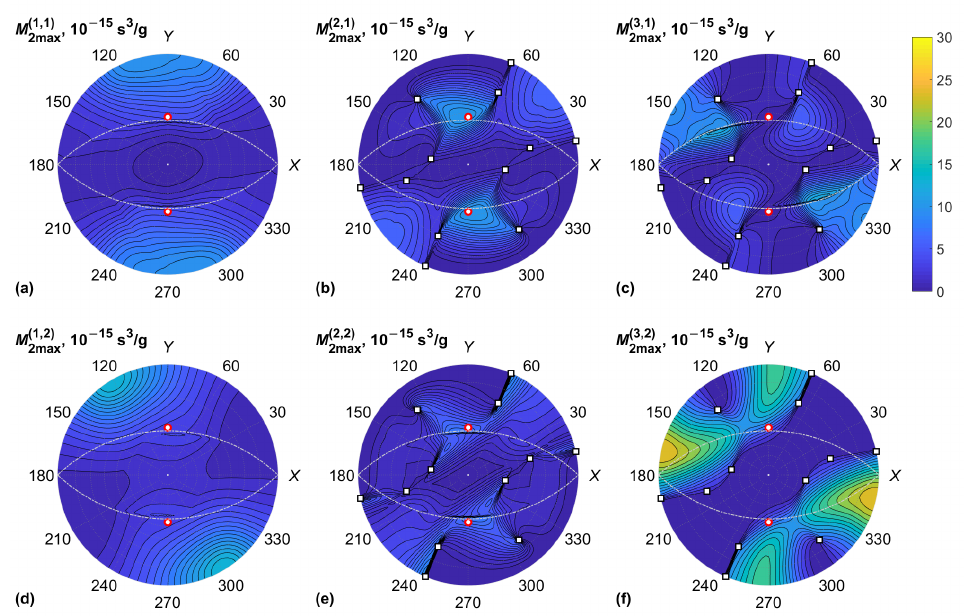
Figure 6. KYW crystal, maximum AO figure of merit: ( a ) QL BAW mode, fast optical mode; ( b ) fast QS BAW mode, fast optical mode; ( c ) slow QS BAW mode, fast optical mode; ( d ) QL BAW mode, slow optical mode; ( e ) fast QS BAW mode, slow optical mode; ( f ) slow QS BAW mode, slow optical mode. Conical acoustic axes of the crystal are marked with squares; optic axes are marked with red circles; directions orthogonal to optic axes are shown with dash-dotted